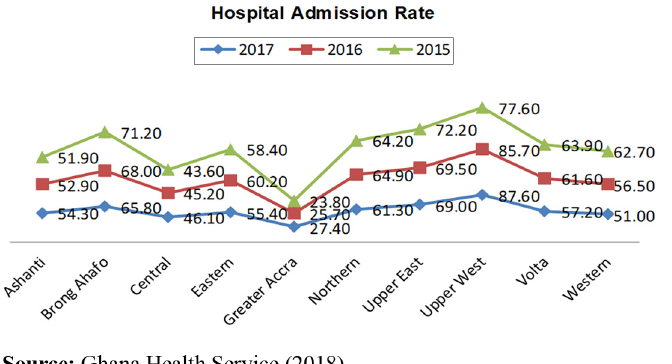
Figure A1. Hospital admission rates by region